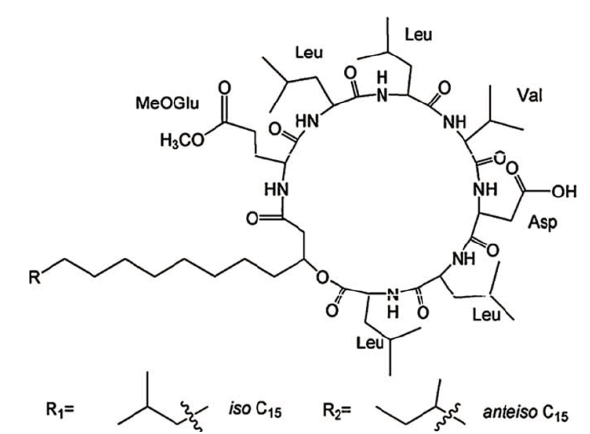
Figure 2. Basic chemical structure of C15-surfactin- O -methyl ester. Reprinted from Process Biochem 44:1144 [23]. Copyright (2009), with permission from Elsevier. Kowall et al. [24] also reported that B. subtilis produced a total of 44 compounds of surfactins and their monomethyl and dimethyl esters, including the known surfactin variants with L -Leu, L -Val, or L -Ile in position 7 of the peptide ring and unknown variants with leucine residues in position 2 and/or 7 replaced by L -Val and L